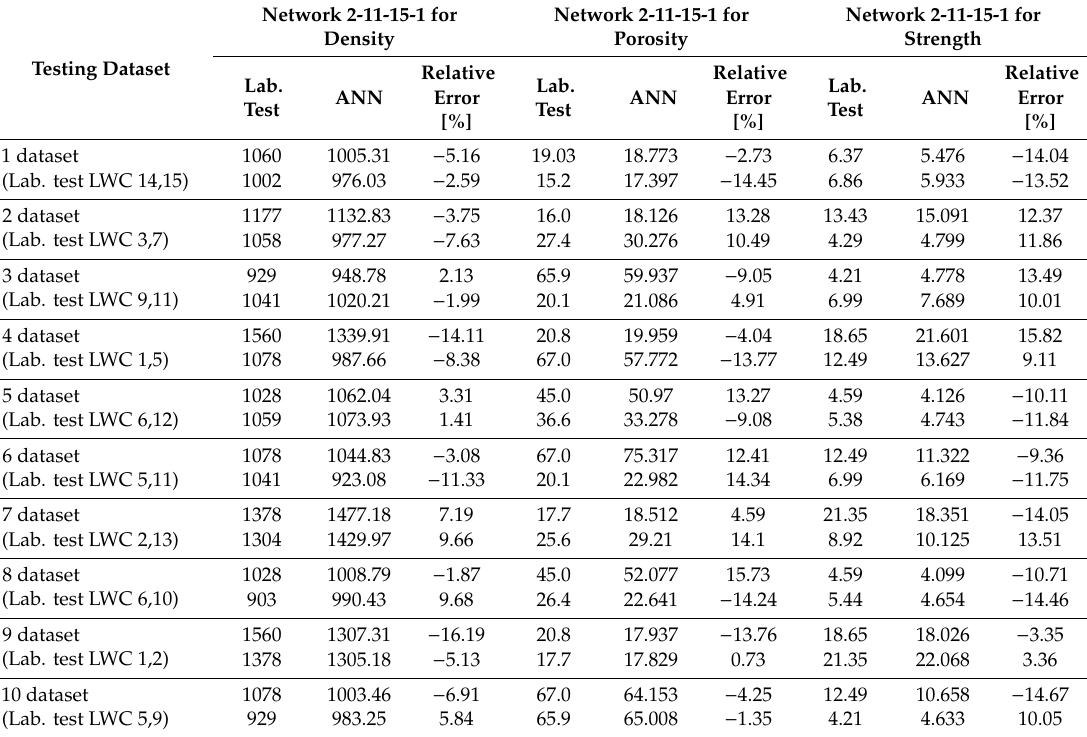
Table 7. Results predicted by the artificial neural networks (ANN) during the validation procedure.